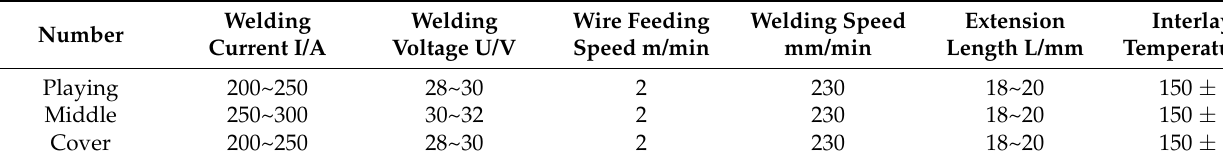
Table 3. Welding process parameters.